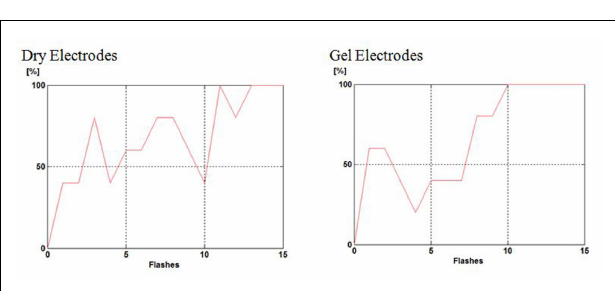
FIGURE 5 | P300 BCI accuracy based on 1–15 flashes for dry vs. gel electrodes for one